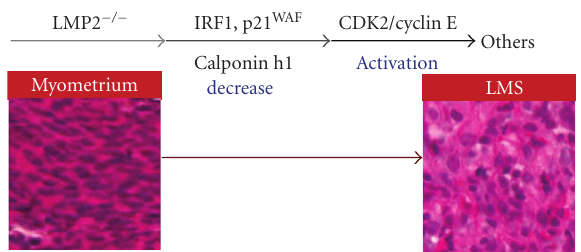
Figure 3: Model of the mechanism for development of uterine leiomyosarcoma. In LMP2-deficient cells, levels of the antionco- genic factor IRF-1, p21 WAF are significantly reduced. Reduced expression of the calponin h1 transcript, which contributes to cell proliferation and tumorigenesis in uterine smooth muscle cells, is detected in uterine LMS tissues. Cell cycle regulatory factors, CDK2/Cyclin E, are markedly activated. The inactivation of such antioncogenic factors is considered to transform LMP2-deficient cells into malignant tumor